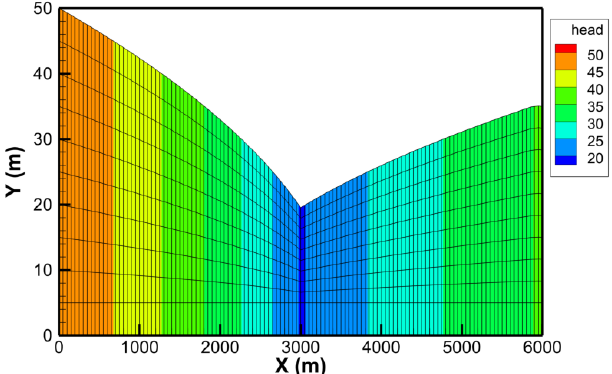
Figure 8. Simulated steady-state water table position and groundwater heads using the adaptive mesh MHFEM technique for the fourth test problem. All horizontal lines of the two-dimensional mesh were allowed to move during the iterative procedure (vertical aspect ratio = 80).